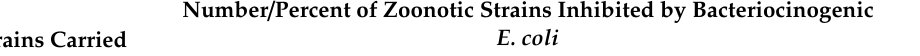
Table 2. Bactericidal potency of bacteriocinogenic commensal E. coli isolates from healthy adults and children, in relation to zoonotic strains resistant and sensitive to